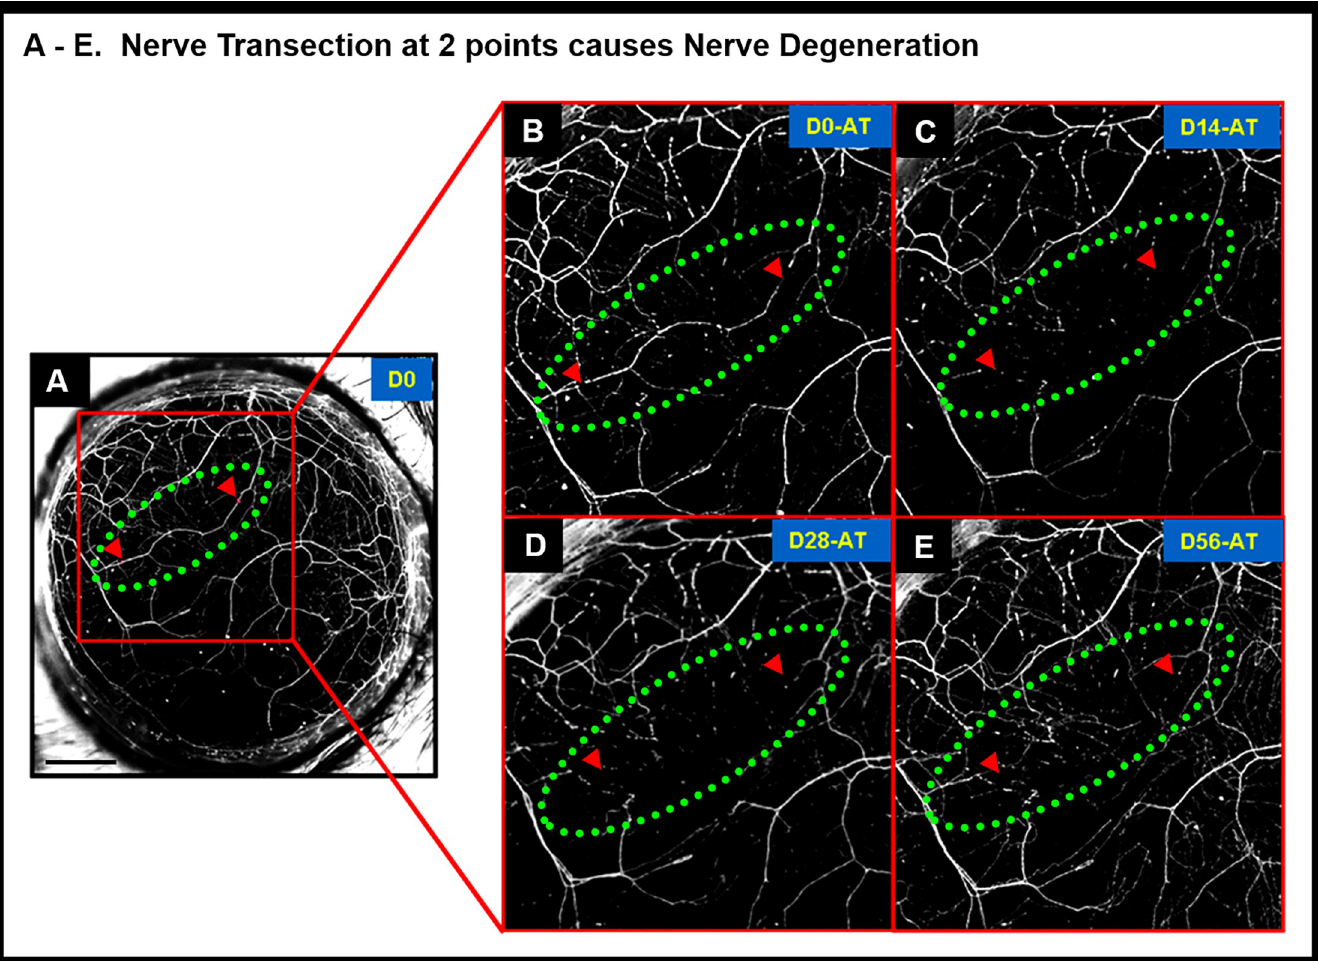
Fig 7. Nerve degeneration in interconnected corneal nerves after two point transection. Nerve transection at 2 points (red arrow heads indicate point of transection) caused loss of YFP fluorescence and disappearance of nerve segment that was enclosed within the cut ends. The red arrow heads depict position of the 2 cuts along the nerve segment (Panel A) and green dotted oval denotes the region of the cut nerve. Panels B, C, D and E are magnified images of the transected nerve at different time points (Days 0, 14, 28 and 56 respectively). In 2-point nerve transections, the nerve segment enclosed within the two laser cuts degenerated and did not result in nerve healing. Black scale bar in Panel A: 500 μ m; AT refers to “after